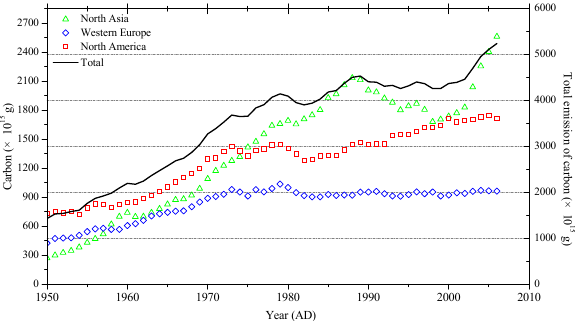
Fig. 7. Fossil fuel CO 2 emissions in these mid-high latitude North- ern Hemisphere regions (Marland et al., 2008). Symbols link to left y-axis and indicate the CO 2 emissions in three different regions: green triangles: North Asia; blue diamonds: Western Europe; red squares: North America. Black line links to right y-axis and stands for the sum of CO 2 emissions from the above three